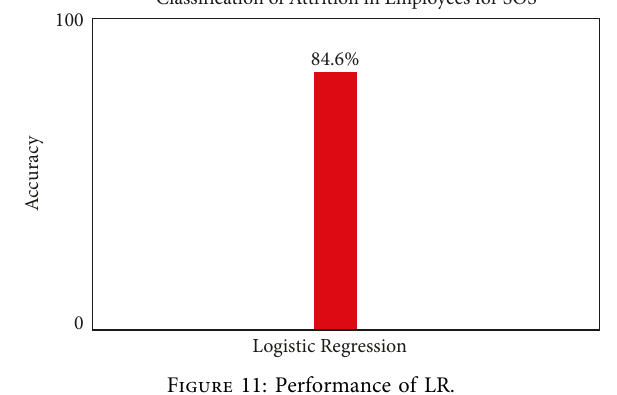
Figure 11: Performance of